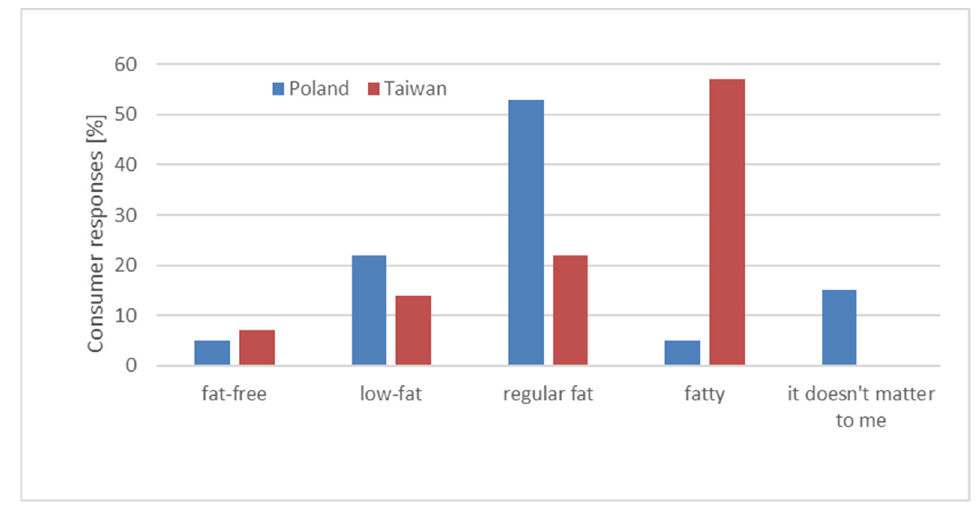
Figure 4. Fat content preferences in yogurt among Polish and Taiwanese respondents.